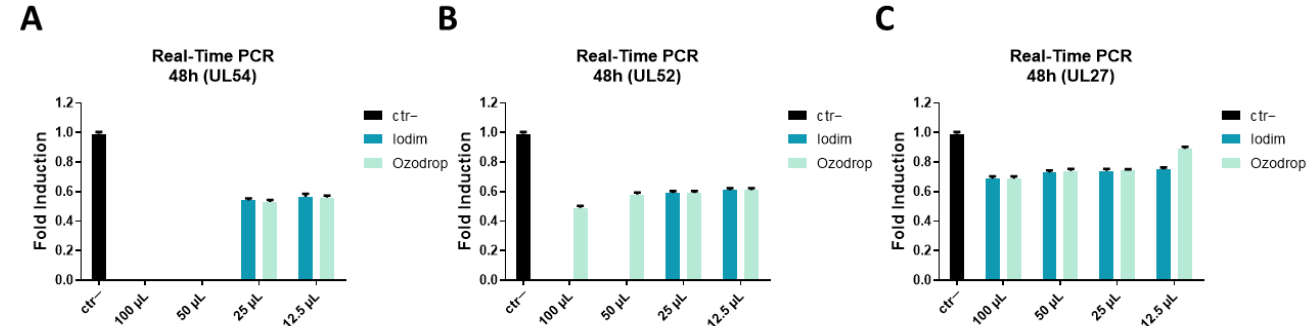
Figure 5. Real-time PCR. A molecular assay was performed to evaluate the effect of ophthalmic solutions on the viral gene expression. Iodim and Ozodrop were tested at different volumes at 48 hpi. The expression of UL54 ( A ), UL52 ( B ), and UL27 ( C ) was analyzed. Data are means of three independent experiments. Ctr- refers to infected, but not treated cells.